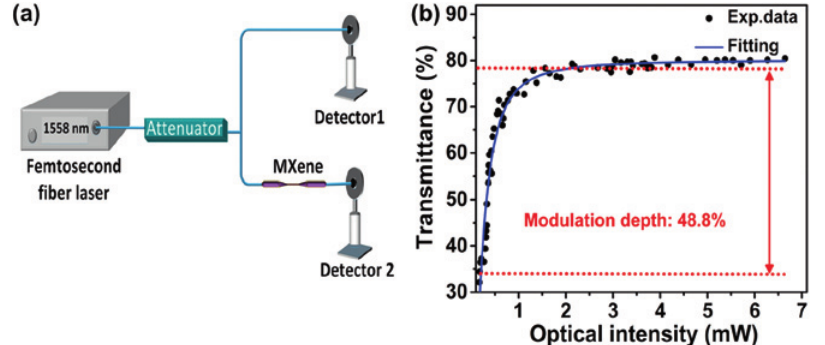
Figure 2: Nonlinear optical measurement of V 2 CT x . (a) Nonlinear transmittance detector system.(b)NonlineartransmissionofV 2 CT x nanosheets at 1558 nm.